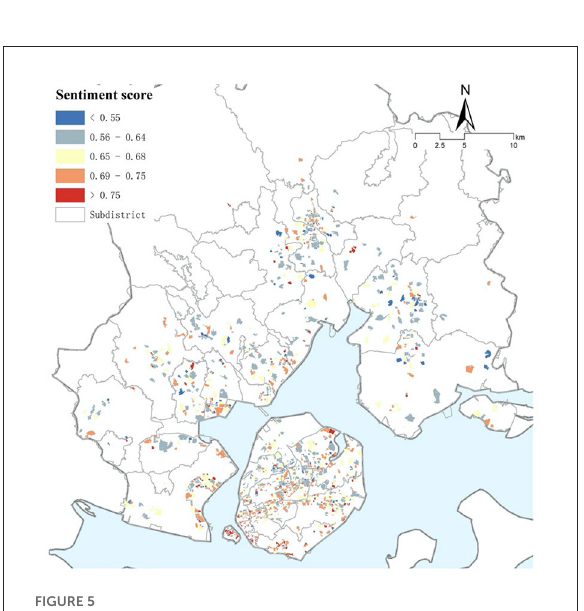
FIGURE5 Neighborhood sentiment scores in Xiamen